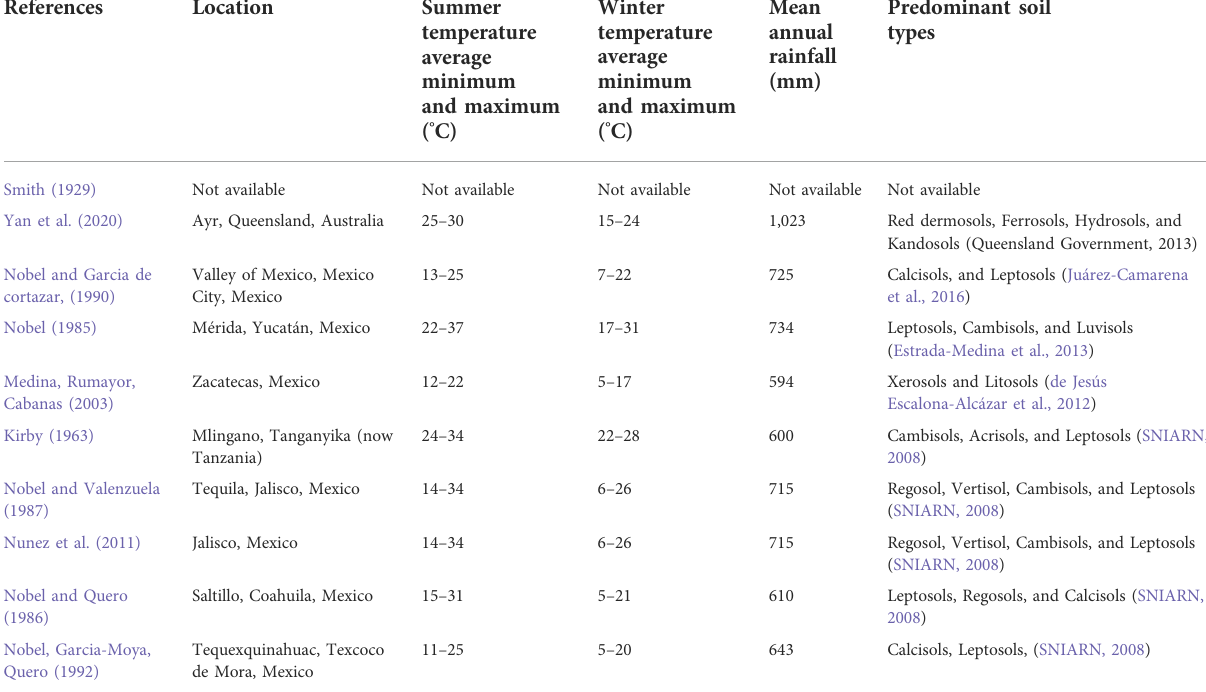
TABLE 3 Current climate conditions for available Agave reference sites used in